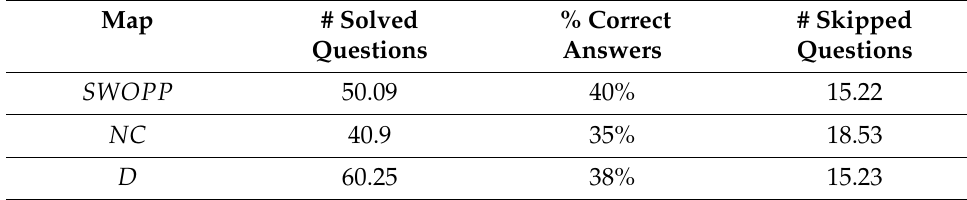
Table 4. Question level